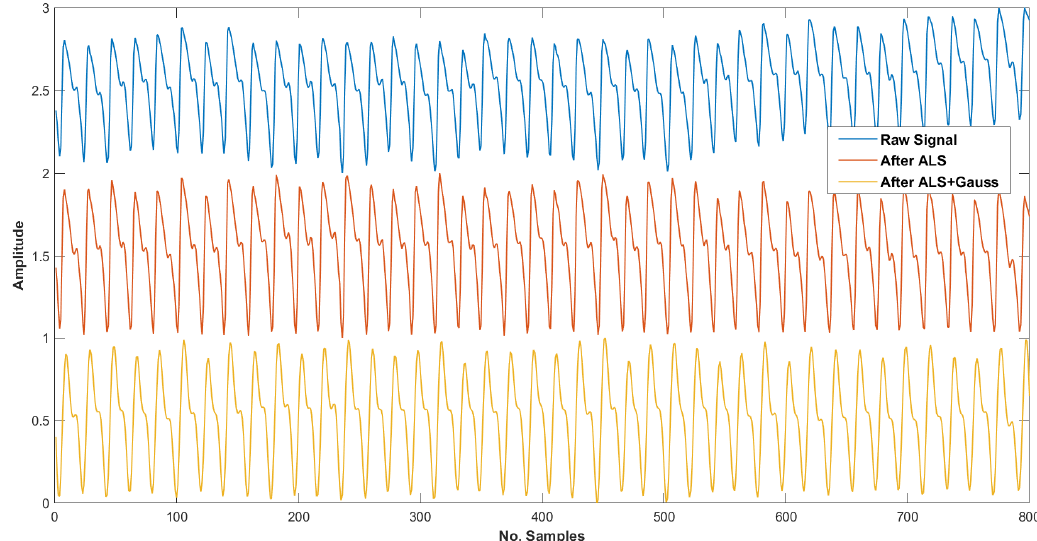
Figure 6. Raw PPG signal ( top ) was first preprocessed with ALS ( middle ) and then cleaned with a Gaussian filter ( bottom ). Both high-frequency noise and baseline variations had been removed.